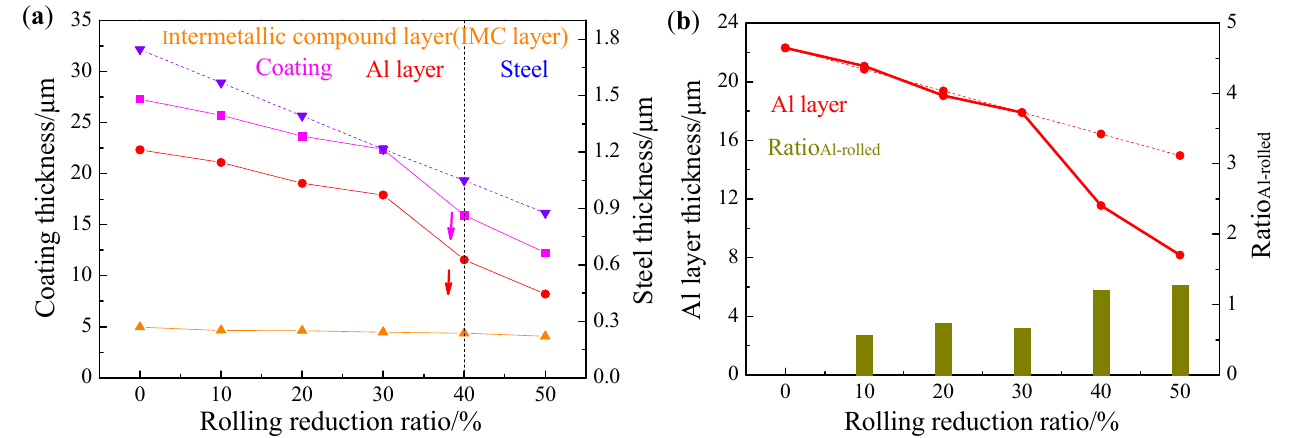
Figure 4. ( a ) AS60/60 coating thickness and steel substrate thickness at different reduction ratios; ( b ) Al layer thickness and Ratio Al-rolled at different reduction ratios.